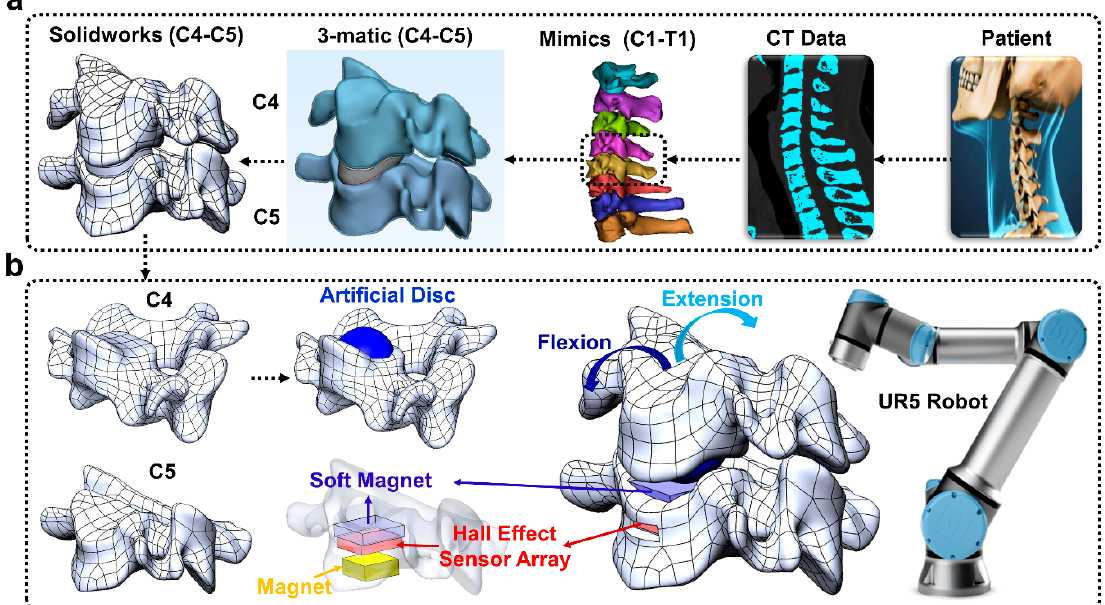
Figure 1. ( a ) Patient-specific robotic spine model based on a CT scan of the spine. ( b ) A modified artificial disc was ‘implanted’ into the C4 cervical spine replica. The soft magnet, Hall effect sensor array board, permanent magnet, and Ecoflex were embedded in the C5 vertebra replica. A robotic arm flexed and extended the cervical spine replica while the intervertebral loads were monitored with the soft magnetic sensor array to classify the spine posture with four different machine learning algorithms.